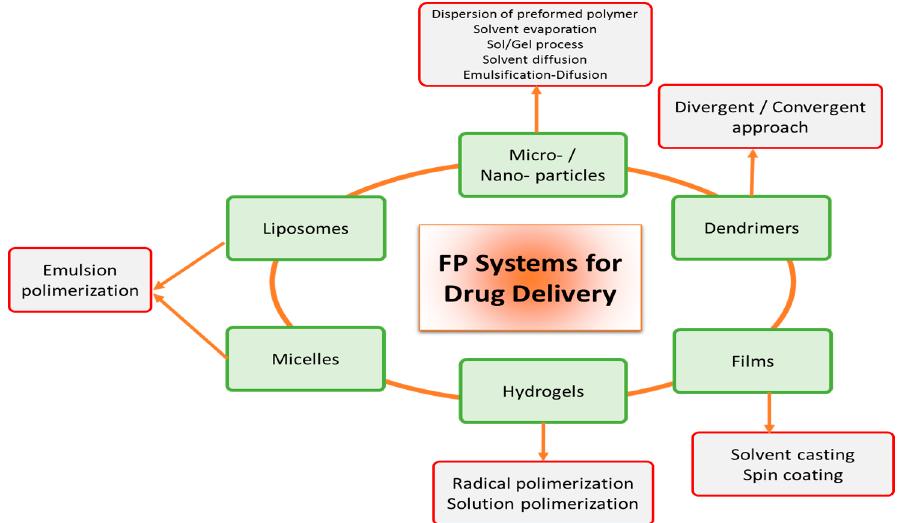
Figure 2. Classification of FP according to their type of synthesis and their skills as drug delivery Figure systems.